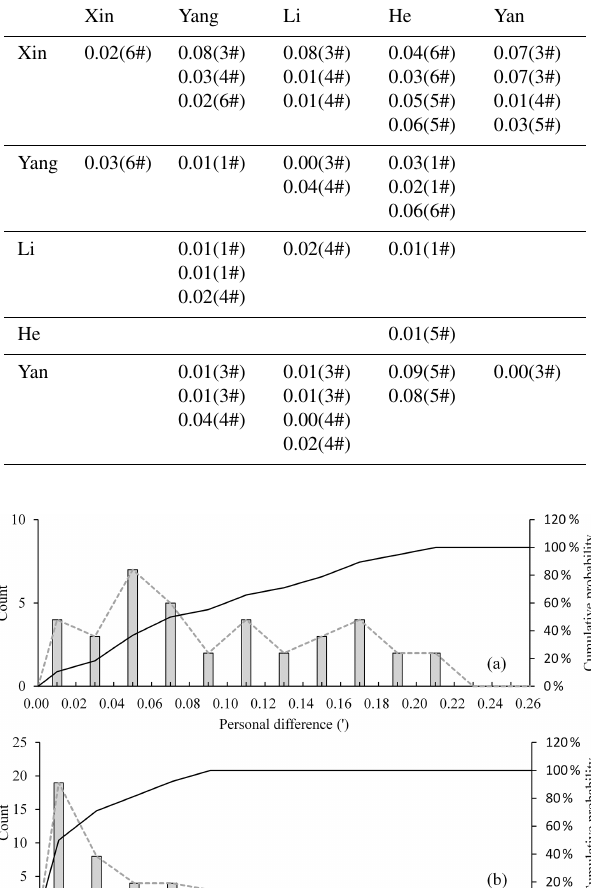
Table 5. The operator differences with respect to inclination. The numbers in parentheses refer to the observation pillars in Fig. 1.